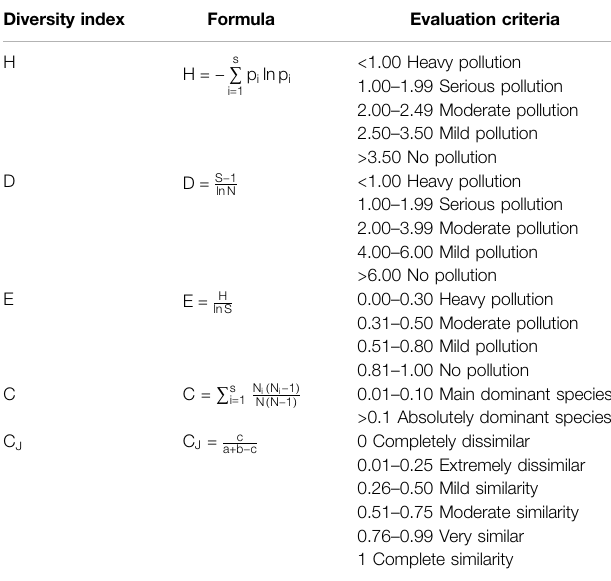
TABLE 2 | Formula principle and evaluation criteria of α diversity index and β diversity index. Diversity index Formula Evaluation